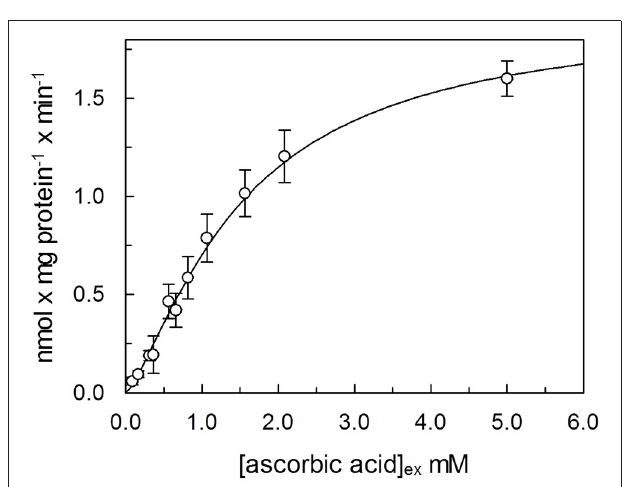
FIGURE 5 | Dependence from substrate concentration of the rate of ascorbic acid transport. [ 14 C]ascorbic acid, at the indicated concentration was added to proteoliposomes. The transport rate for each experimental point was calculated, as described in Methods, as product of velocity constant ( k ) × limit, derived from a time course, for each external concentration of ascorbic acid. Data were plotted according to Hill plot. Data are means of five